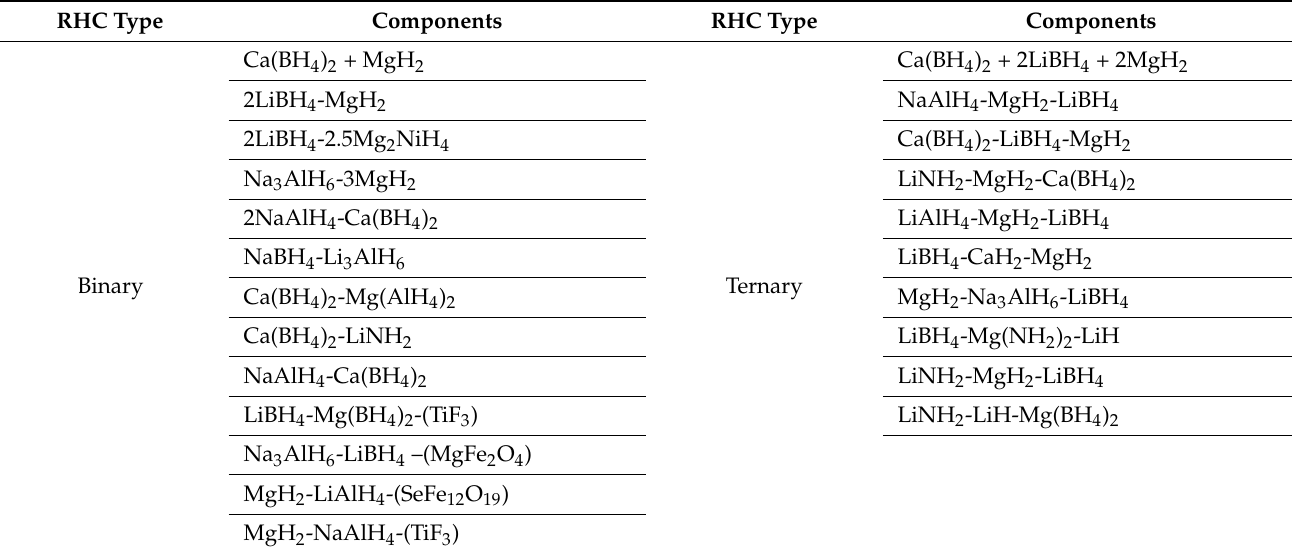
Table 3. Examples of binary and tertiary RHC with corresponding